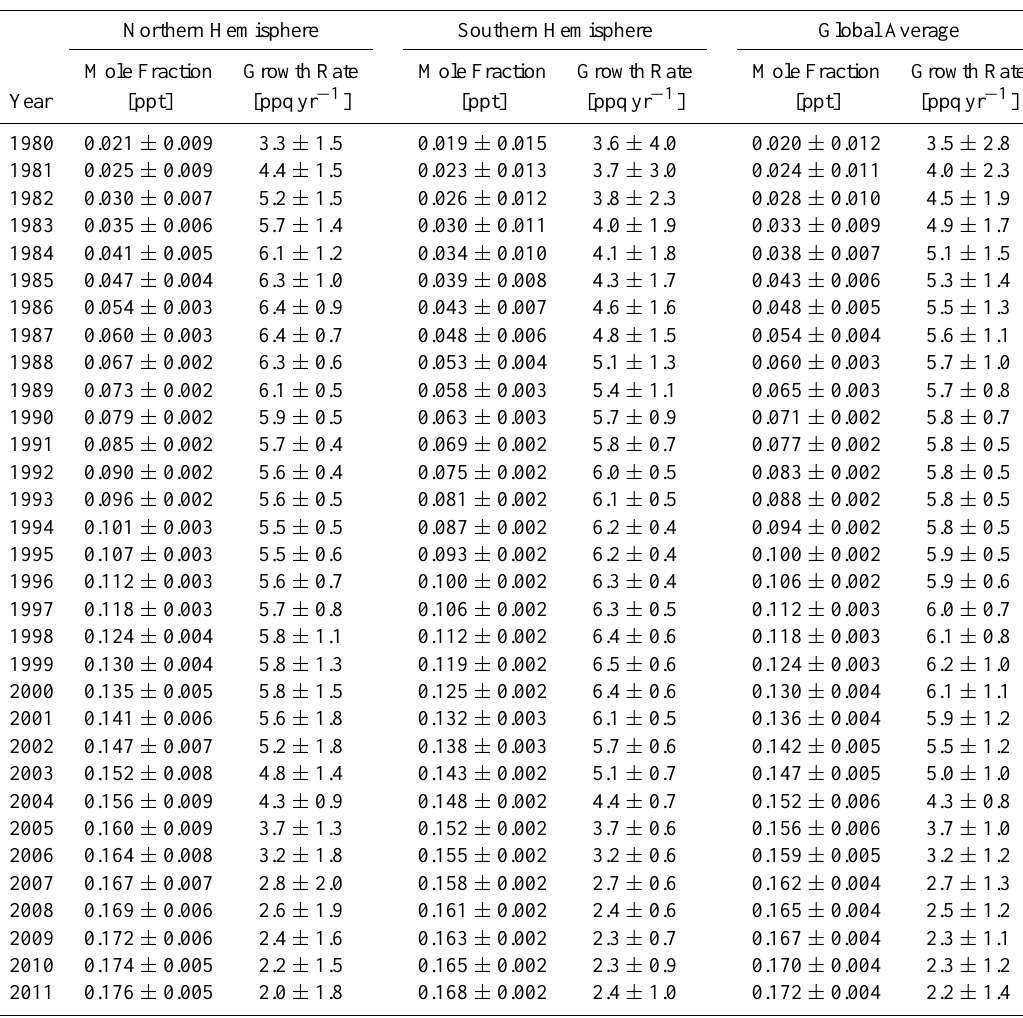
Table 3. Northern and Southern Hemisphere and Global Average Annual Mean Mole Fractions and Growth Rates and Associated Uncer- tainties 1980-2011 for C 4 F 10 .